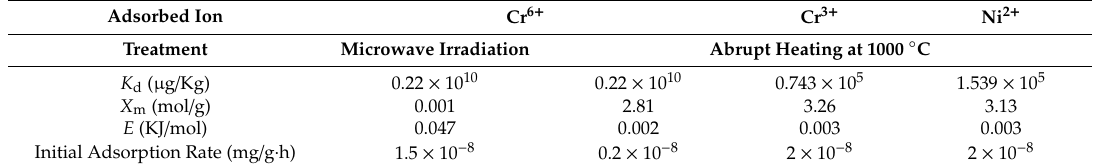
Table 7. Comparison of Cr 6 + adsorbed values, maximum adsorption capacity ( X m ), adsorption energy ( E ) and initial Cr 6 + adsorption rate obtained in this research with CHGE − H and CHGE − MW in distilled water with those obtained by [12] for Cr 3 + and Ni 2 + with CHGE − H in synthetic seawater. Adsorbed Ion Cr 6 + Cr 3 + Ni 2 +